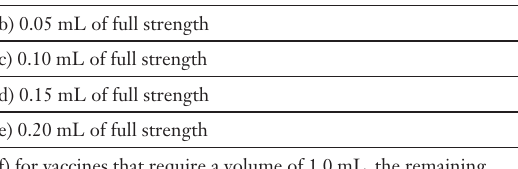
Proposal of adminis- tration of vaccines in patients with positive SPT for the respec- tive vaccine and absolute need for vaccination